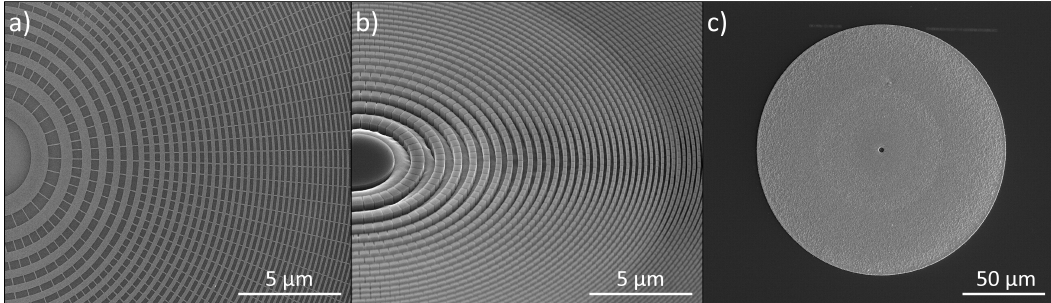
Figure 2. SEM micrographs of ( a ) Au patterned Si substrate (top-view), ( b ) MACE processed Si zone plate mold (52 ◦ -tilt view), and ( c ) ELD metalized Pd/Si zone plate showing selective plating in the zone plate area only